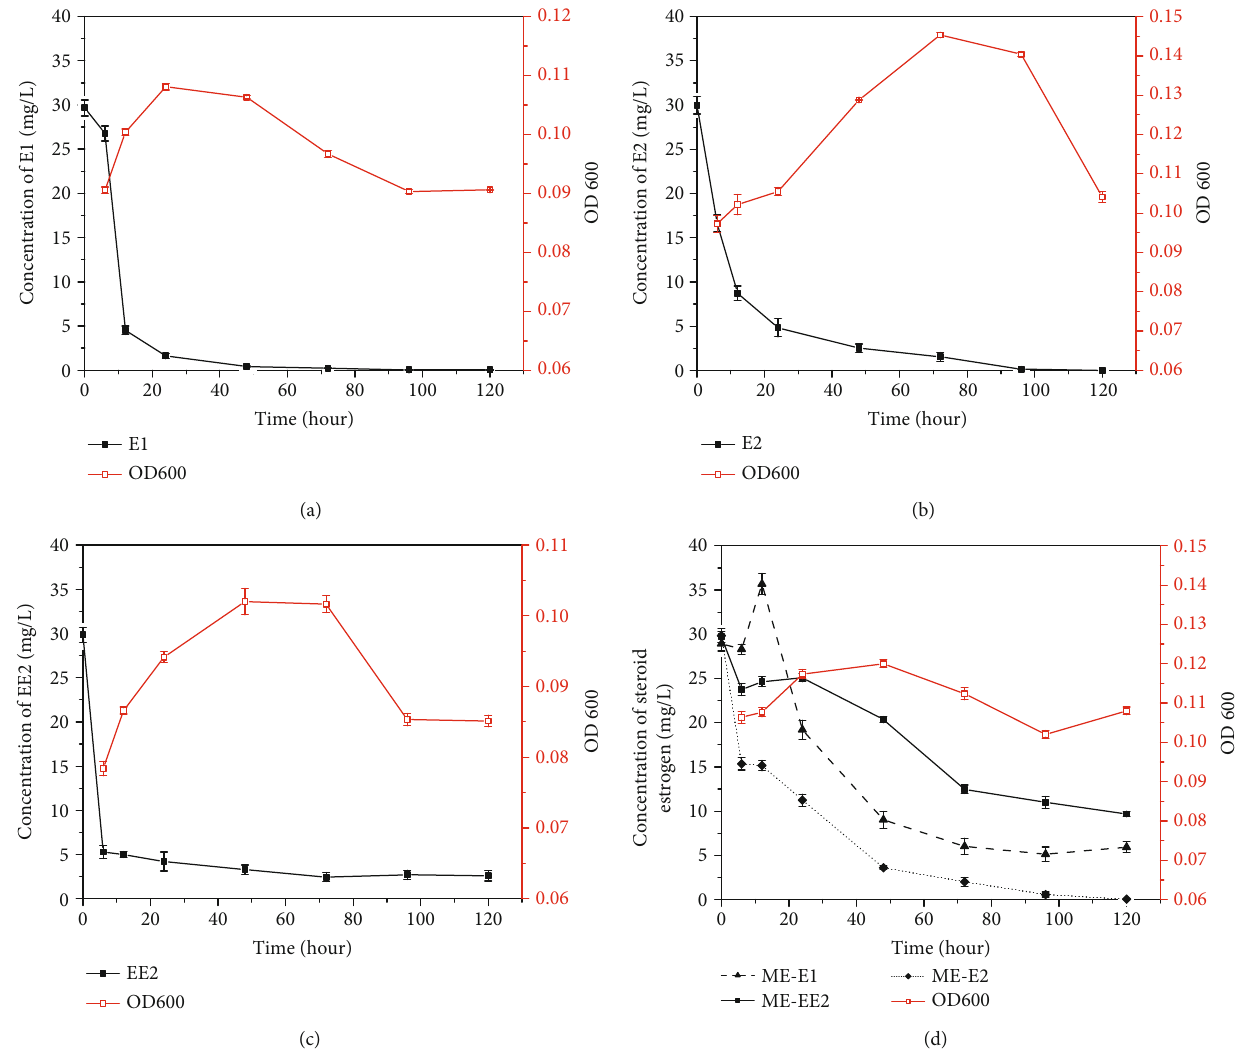
Figure 1: Biodegradation curve and growth curve of strain R-001 on three estrogens. (a) R-001 degrading E1. (b) R-001 degrading E2. (c) R- 001 degrading EE2. (d) R-001 degrading mixed